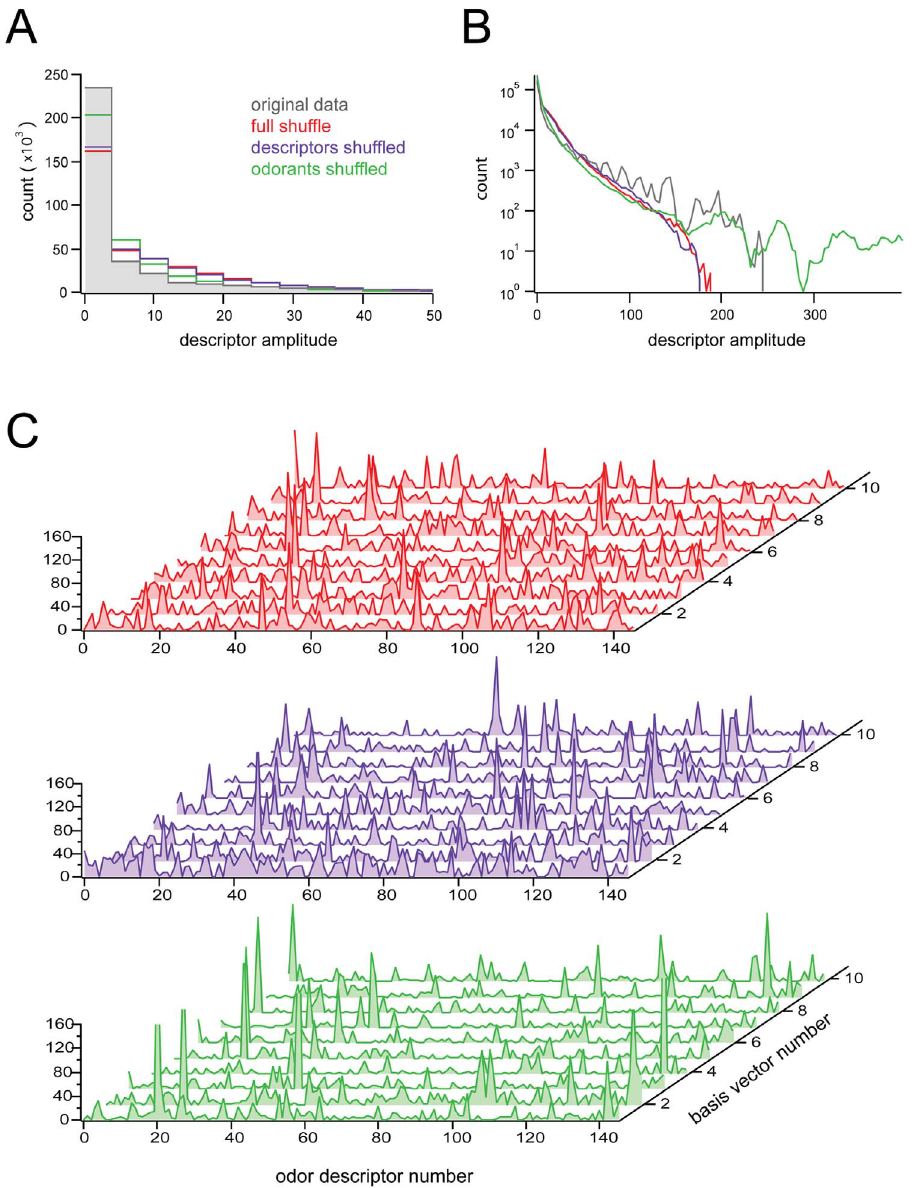
Figure 3. NMF on full, descriptor-only, and odor-only shuffled versions of the data. A ð Þ Peak behavior of histograms obtained from NMF performed on shuffled data, for each of the various shuffling conditions (see text for descriptions). B ð Þ Tail behavior of histograms, same procedure and conditions as in A ð Þ ; note difference in scaling of axes between A ð Þ and B ð Þ . C ð Þ Waterfall plots of basis sets obtained when NMF was applied on shuffled data, for various shuffling conditions. Note the comparative lack of sparseness, relative to the basis set shown in Fig. 3A. Reproducibility of basis vectors across iterations of NMF for shuffled data sets was eliminated, or severely compromised, as shown in Fig. 4.